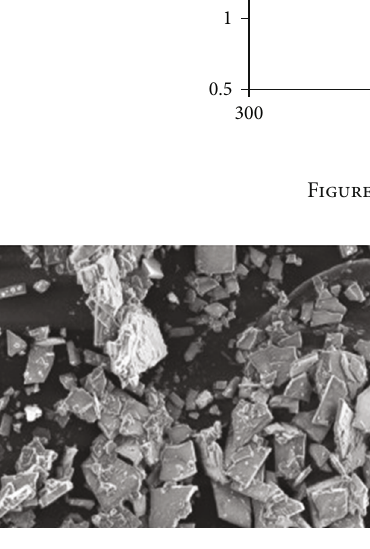
6: Antimicrobial activity of